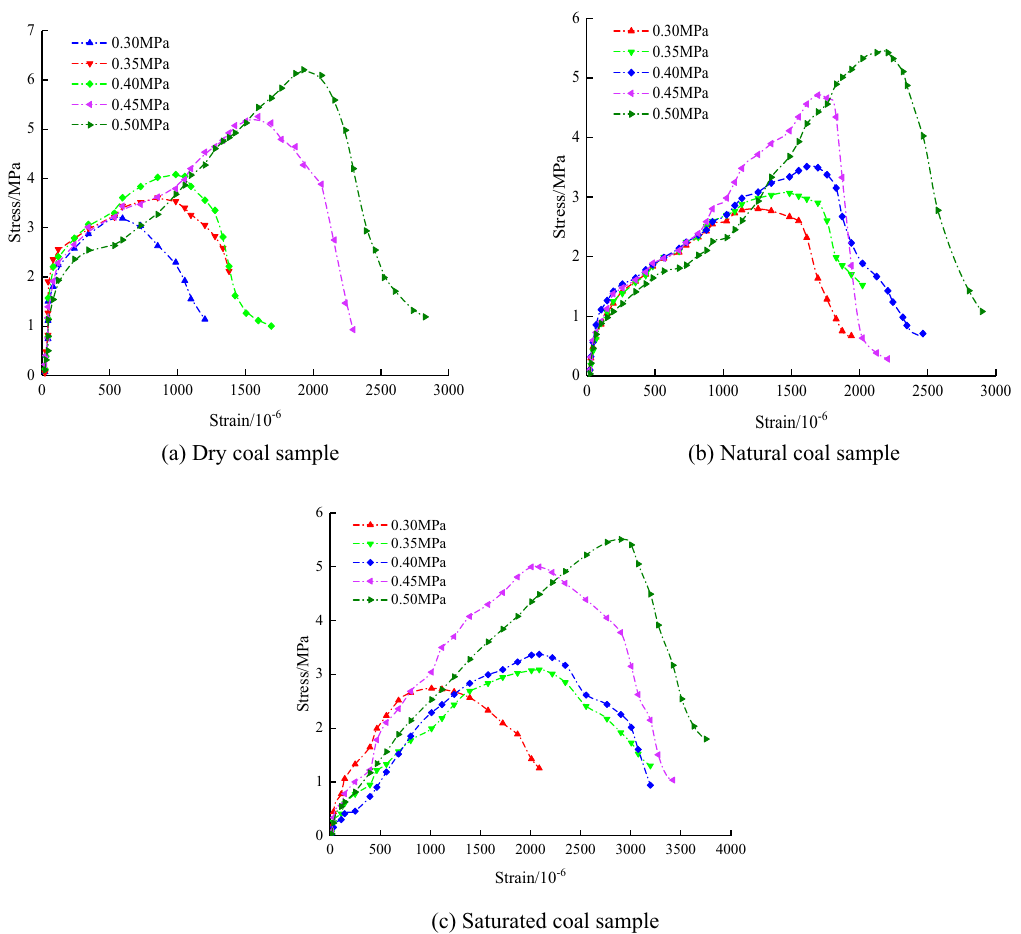
Figure 4. Dynamic stress–strain curves of coal samples under different loading